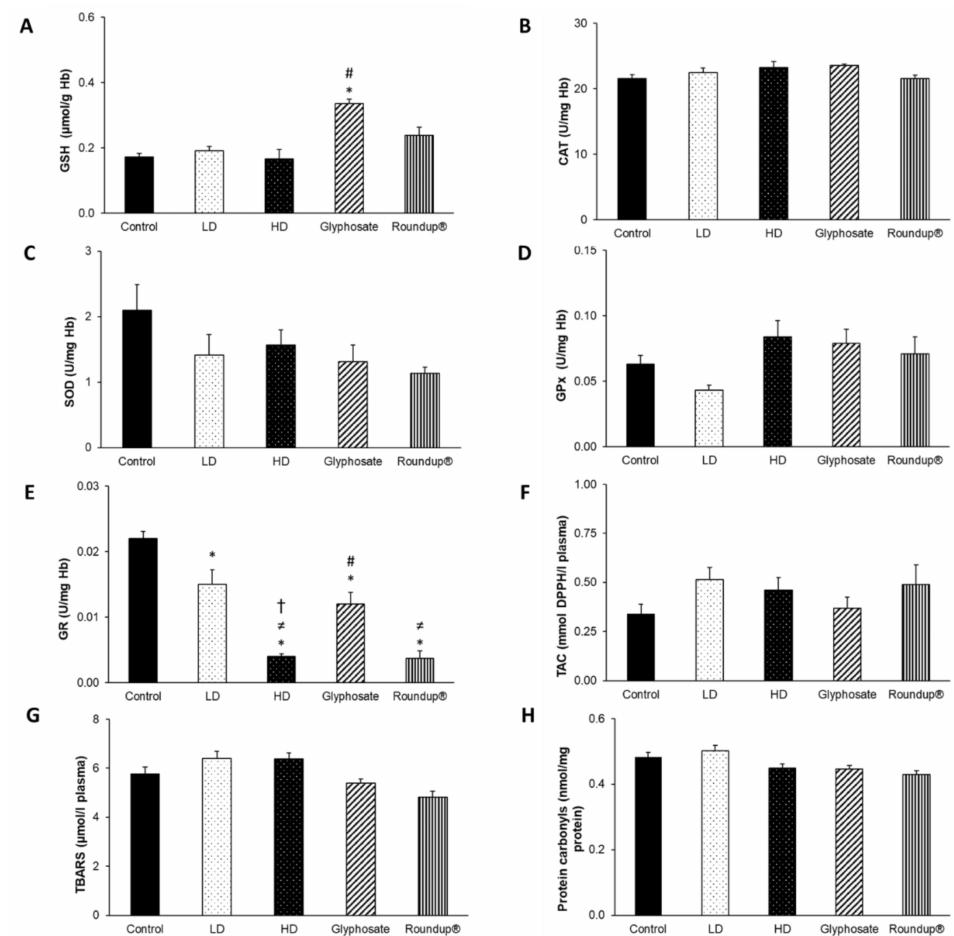
Figure 2. The effects of 3-month exposure of New Zealand rabbits to the EDs mixture, glyphosate, and Roundup ® on blood GSH concentration ( A ), CAT activity ( B ), SOD activity ( C ), GPx activity ( D ), GR activity ( E ), TAC levels ( F ), TBARS levels ( G ), and protein carbonyls concentration ( H ). *: Statistically significant difference compared to the control group. #: Statistically significant difference compared to the HD group. (cid:54) = : Statistically significant difference compared to LD group. †: Statistically significant difference compared to glyphosate